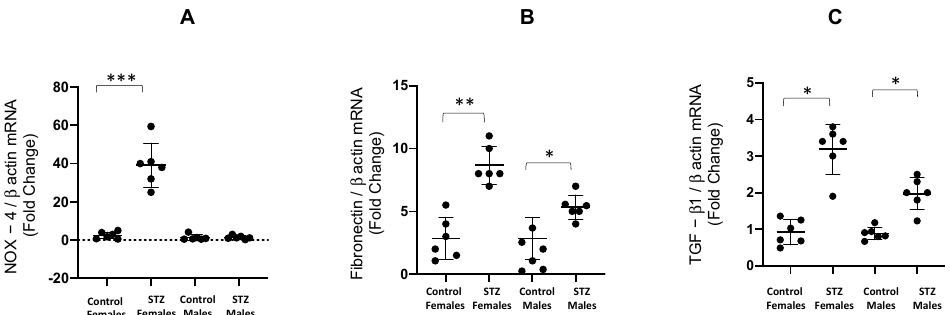
Figure 3. mRNA expression of NOX4, fibronectin and TGF- β 1 in kidney medullary tissues from male and female control and STZ mice. After 6 days of single STZ administration, NOX-4 mRNA/ β -actin mRNA ratio was significantly augmented in female STZ mice compared to control female mice. This increase was not observed in male STZ mice ( A ). Fibronectin mRNA/ β -actin mRNA ratios were augmented in male STZ mice and, to a lesser extent, in females ( B ). TGF- β 1 mRNA/ β -actin mRNA ratios were augmented in STZ females and male mice ( C ). * p < 0.05 vs. control group, ** p < 0.01 vs. control group; *** p < 0.001 vs. control group.